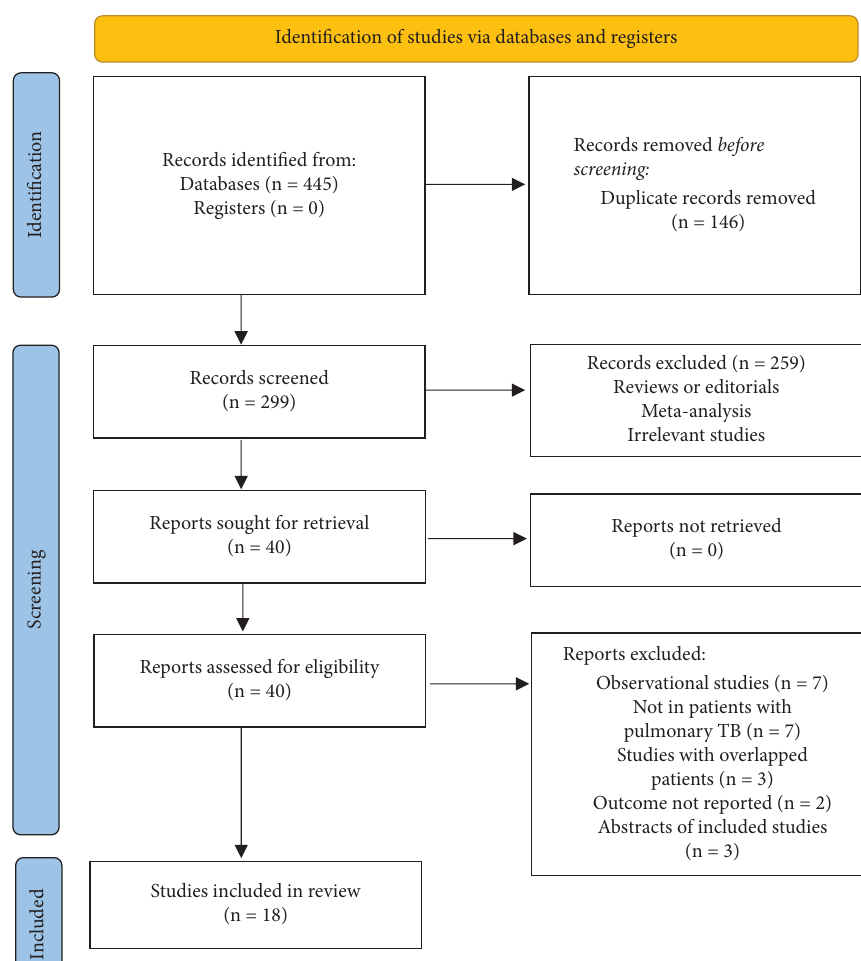
Figure 1: Flowchart of literature